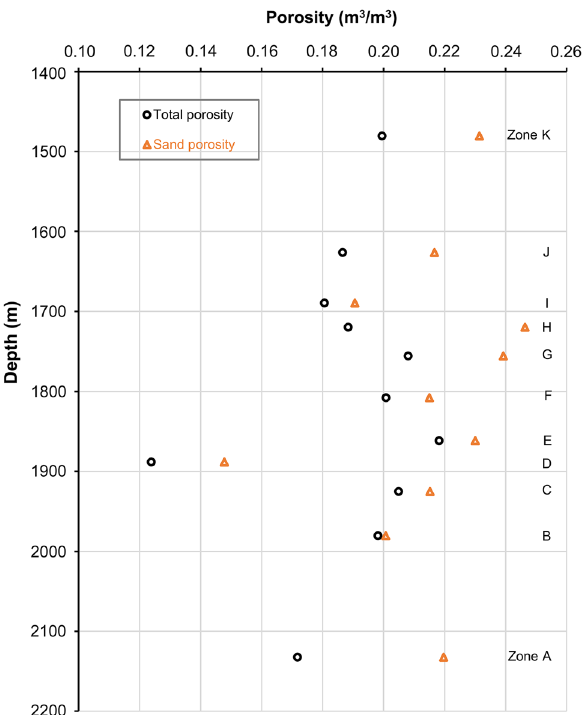
Fig. 10 Porosity against depth plot, where total porosities (black-cir- cle markers) were derived from density log and orange-triangle mark- ers are the shale laminae-free sand (or shaly sand) porosities derived from the Thomas–Stieber method